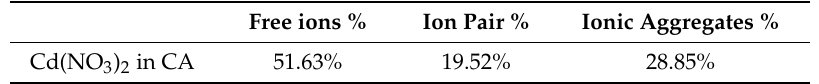
Figure 6. Deconvoluted Raman spectra for NO 3 − in the CA / Cd(NO 3 ) 2 · 4H 2 O composite. Based on these results, the Cd(NO 3 ) 2 incorporated into the polymer existed as abundant free ions in the polymer chain as shown in Table 2. Table 2. Comparison of free ions, ion pair, and ionic aggregates % for NO 3 − in Cd(NO 3 ) 2 in CA.